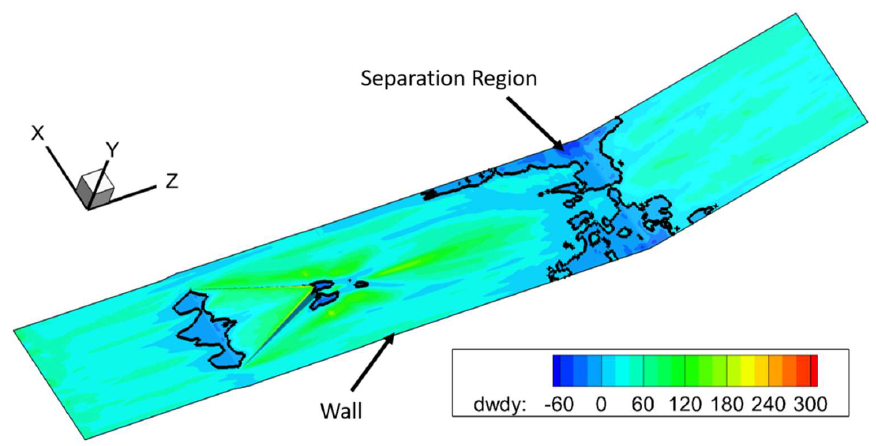
Figure 6. In time-average view, the reduced flow separation due to the vortex rings is generated by MVG.